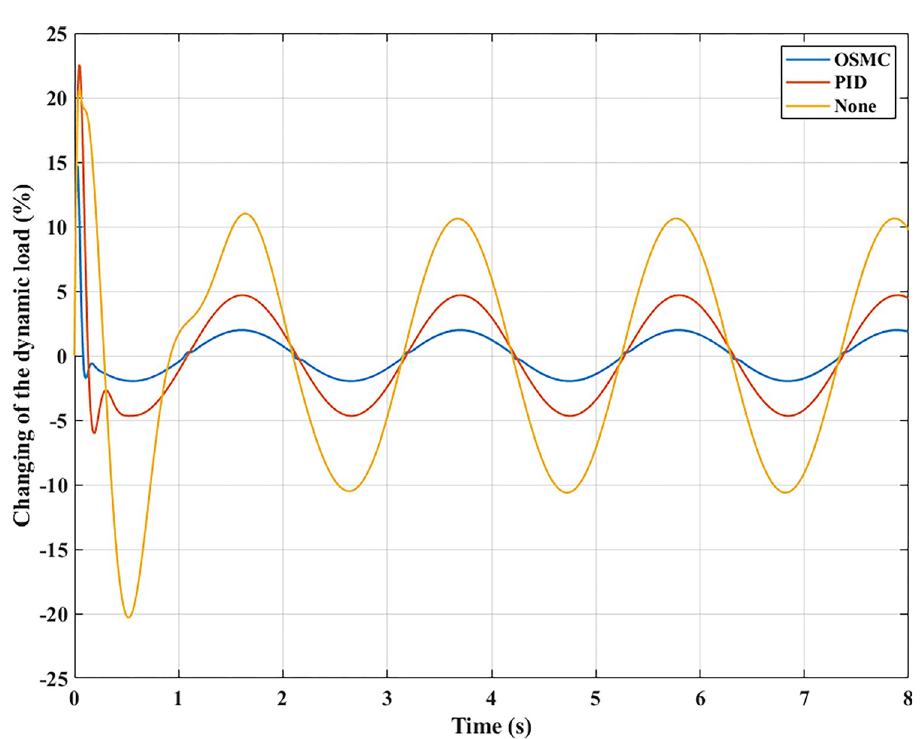
Fig 18. Changing the dynamic load (case 2).